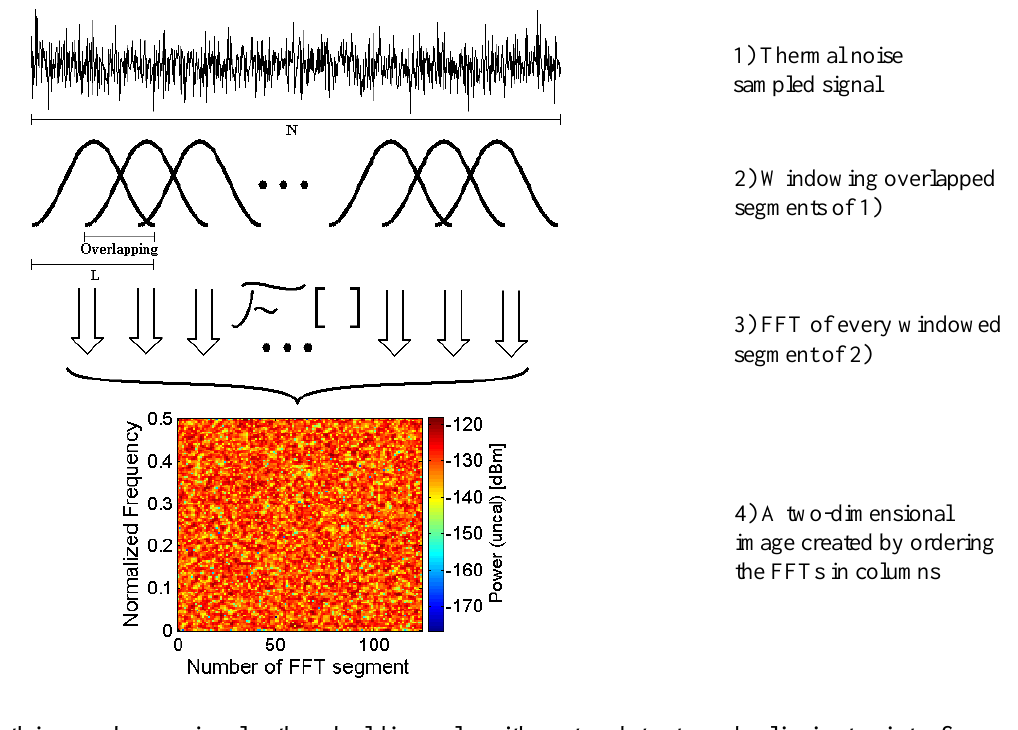
Figure 1. Process of obtaining a Spectrogram from a sampled signal of thermal